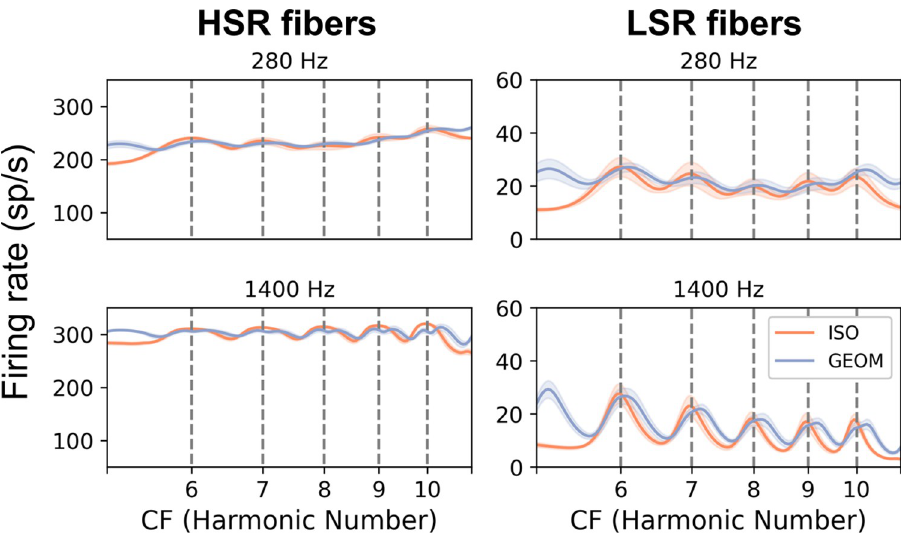
Fig 4. Comparison of the availability of spectrally resolved harmonics at low and high frequencies in an excitation pattern simulation. Excitation patterns (average firing rate versus CF) for high-spontaneous-rate (HSR) auditory- nerve fibers (left) and low-spontaneous-rate (LSR) auditory-nerve fibers (right) responding to the stimuli in Experiment 1b based on a computational model of the auditory periphery [52]. The solid curve indicates the average excitation pattern while the filled area around the curve indicates ± 1 standard deviation (over 10 simulations with different samples of masking noise and level roving). Vertical dashed lines indicate the frequencies of target harmonics. The F0 difference between the target and masker was 3%. See Materials and Methods for more details on the simulations.